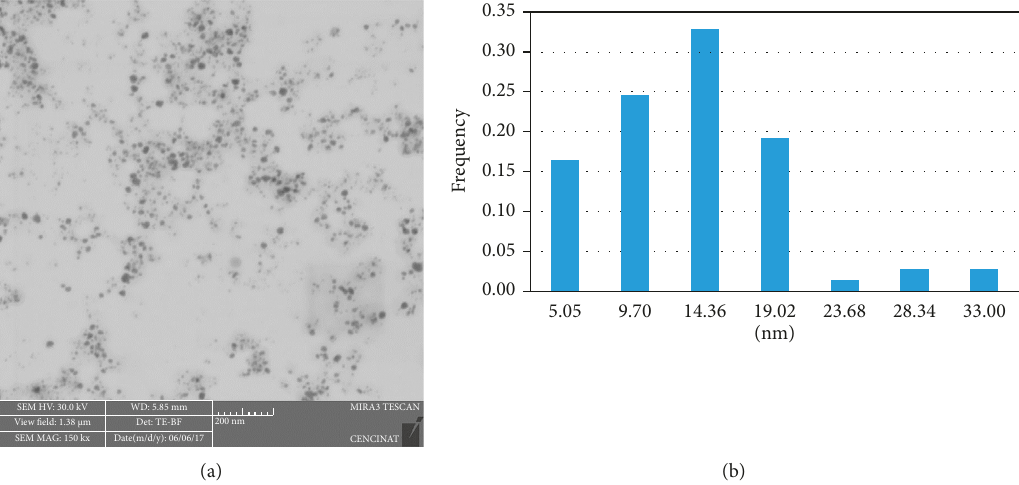
Figure 4: STEM image (a) and frequency histogram (b) of average shape of silver nanoparticles- A. arborescens extract.